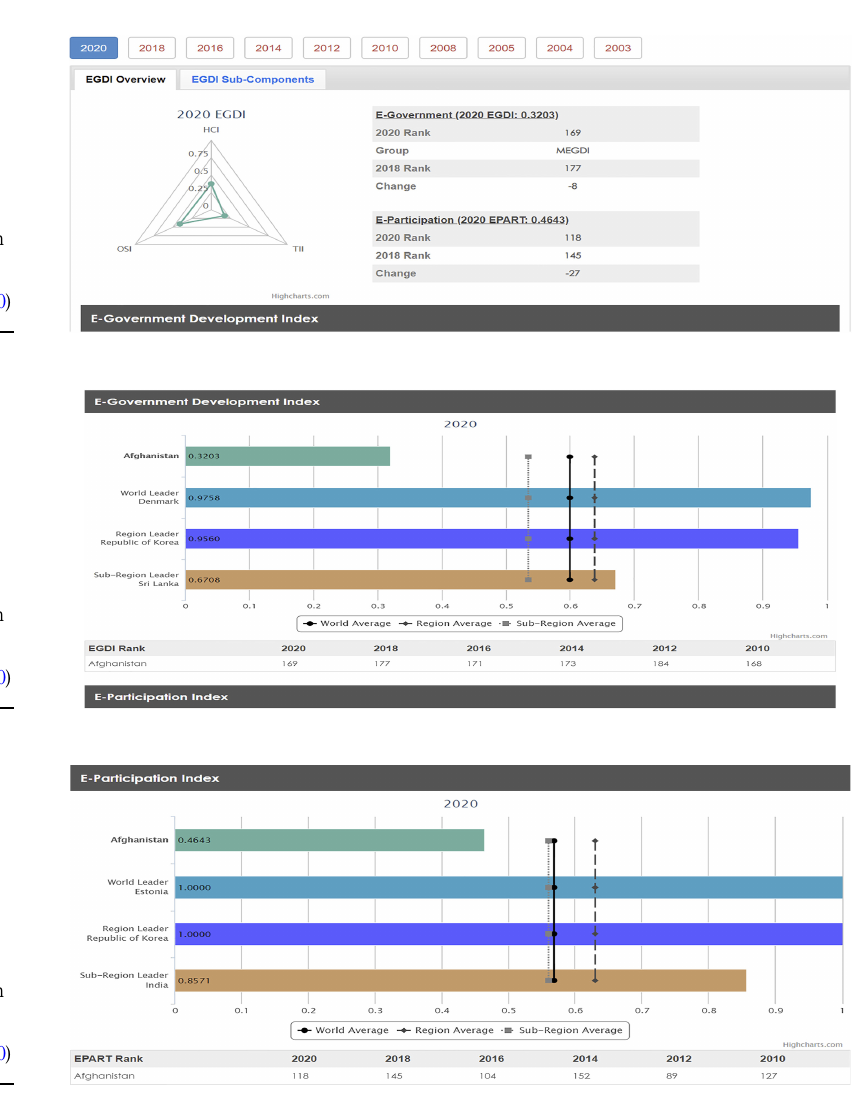
Figure 3. Afghanistan status in UN e-Government survey (2010,